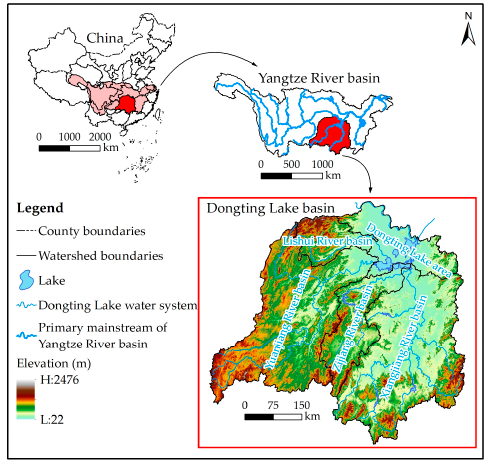
Figure 1. Location and terrain map of the Dongting Lake Basin (DLB, map of China from China Standard Map Service GS (2020) 4619).